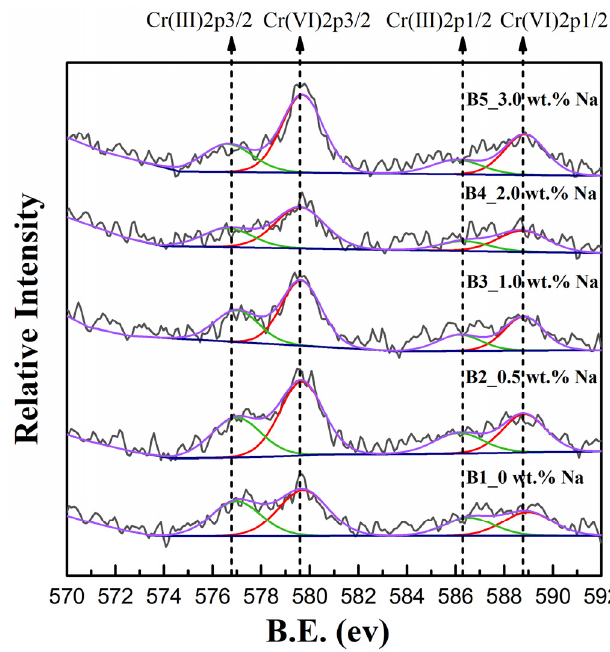
Figure 2. Samples (A1–A5, B1–B5 and C1–C5) after powdering.